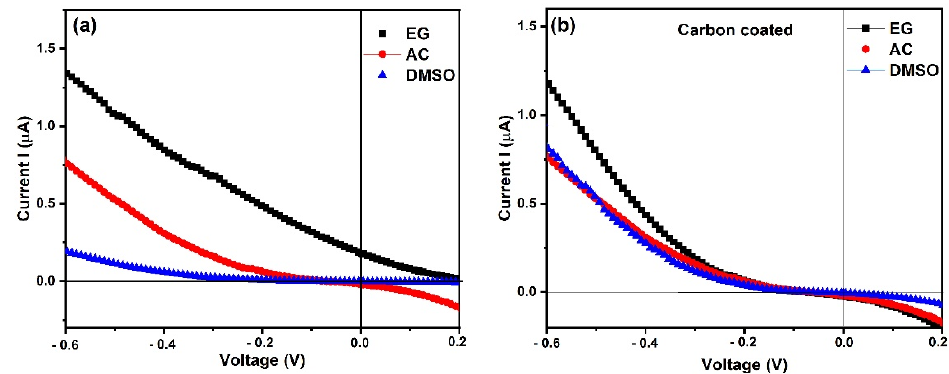
Figure 6. Current–voltage measurement of ( a ) Si-PEDOT: PSS wafers and ( b ) carbon coated Si-PEDOT: PSS wafers. Table 3. Comparison of the performance of this work with others reported in the literature S. No.